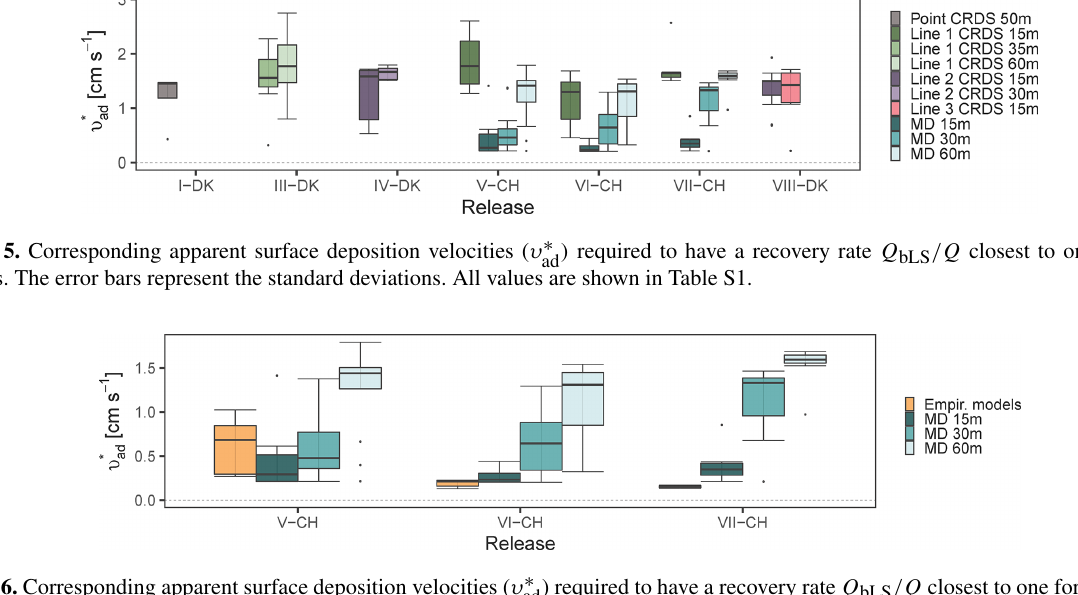
) required to have a recovery rate Q bLS /Q closest to one for miniDOAS ad calculated with an empirical ad